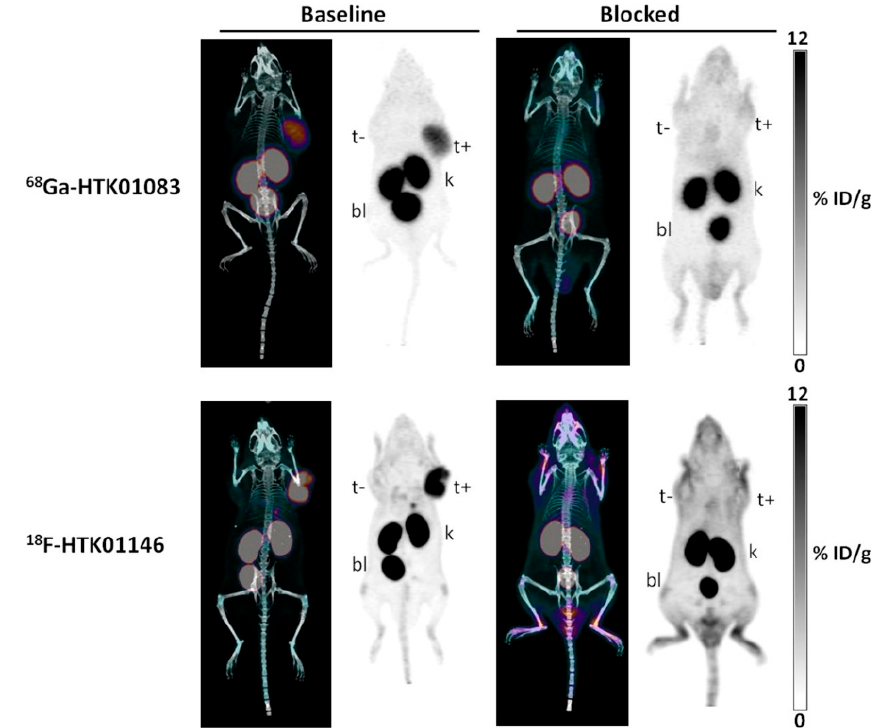
Figure 9. Maximal intensity projection images of PET/CT and PET with 68 Ga-HTK01083 and 18 F-HTK01146 in mice bearing HEK293T and HEK293T::hB1R tumors at 1 h post-injection. Blocking studies were performed with co-injection of 100 µg of R954. t+, B1R+ tumor; t − , B1R- tumor; k, kidney; bl, bladder. Figure adapted from Kuo, H.T.; et al. [83].